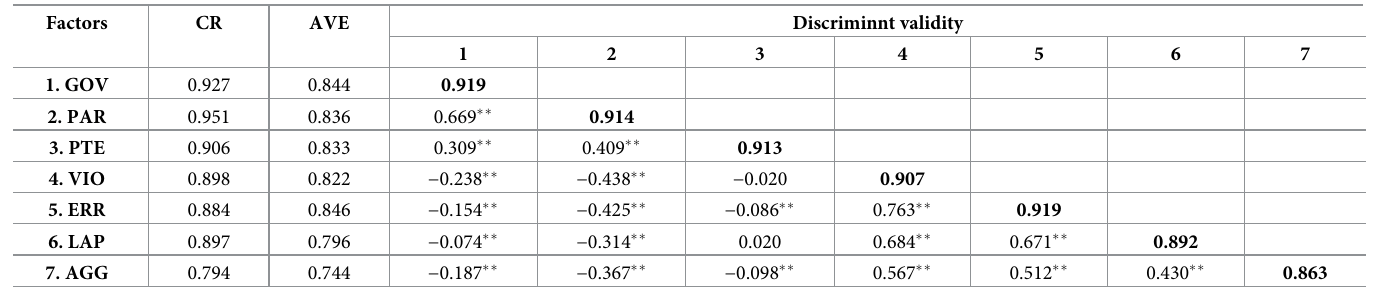
Square root of average variance extracted shown on diagonal in